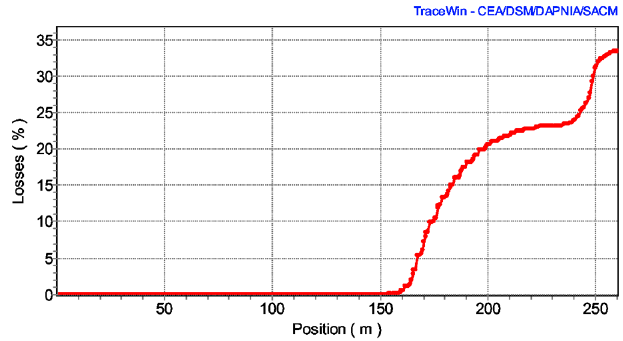
FIG. 11. (Color) Losses along the linac at 220 (cid:4) s